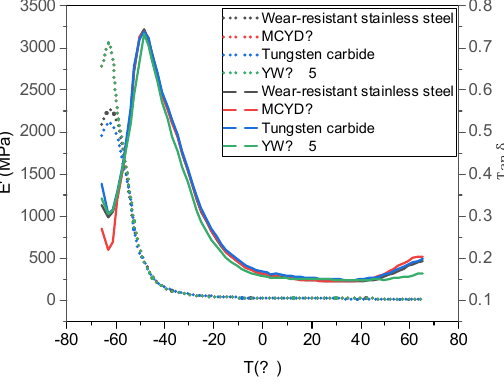
Figure 7. DMA test curve. Table 7. TG and Tan δ of NR/BR composites after friction with different